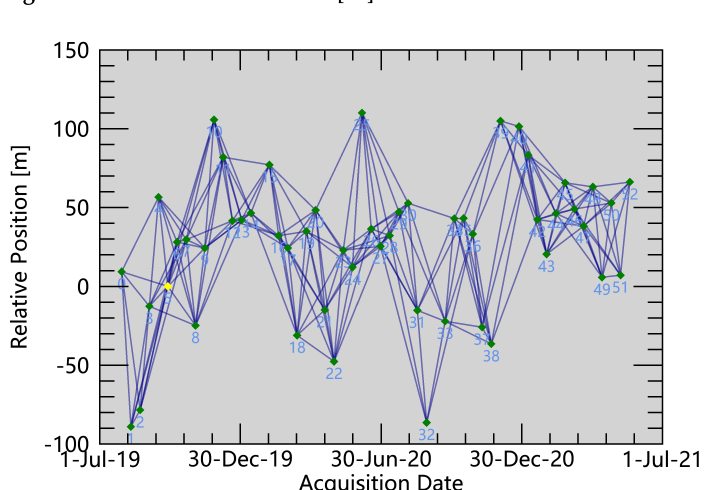
Figure 4. SBAS-InSAR flow chart [22].